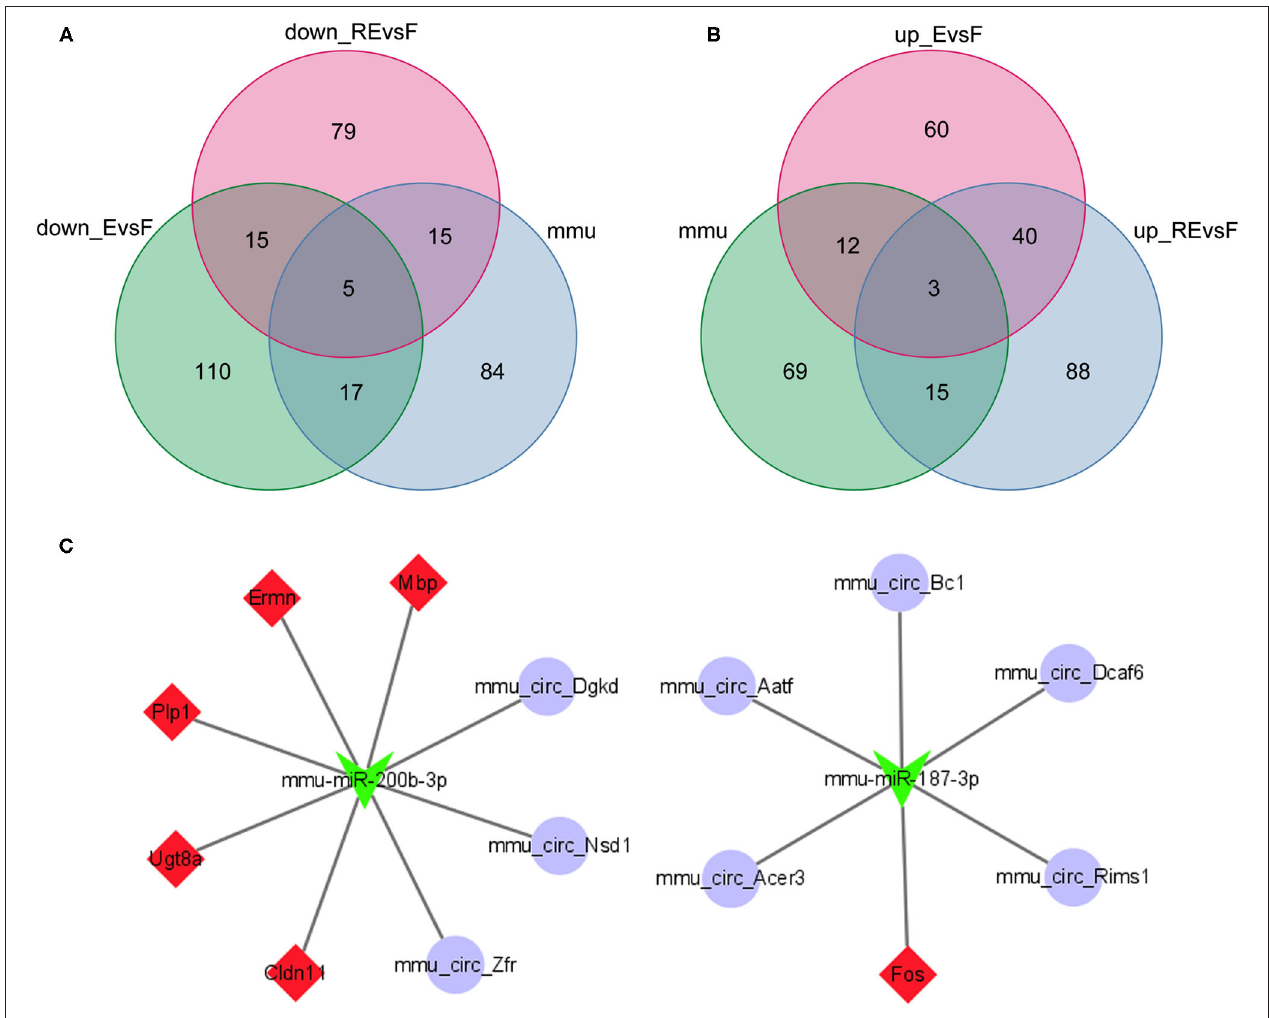
FIGURE 8 | Two circRNA-associated networks were established between F and E/RE. (A,B) The obtained circRNAs were presented by the Venn diagram. (C) The circRNA-associated ceRNA networks in F and E/RE. The purple circles represented circRNAs, the green arrowhead represented miRNAs, and the red diamonds represented target mRNAs. Network edges represented competitive interactions. F, fear memory formation group. E, fear memory extinction group. RE, retrieval-extinction